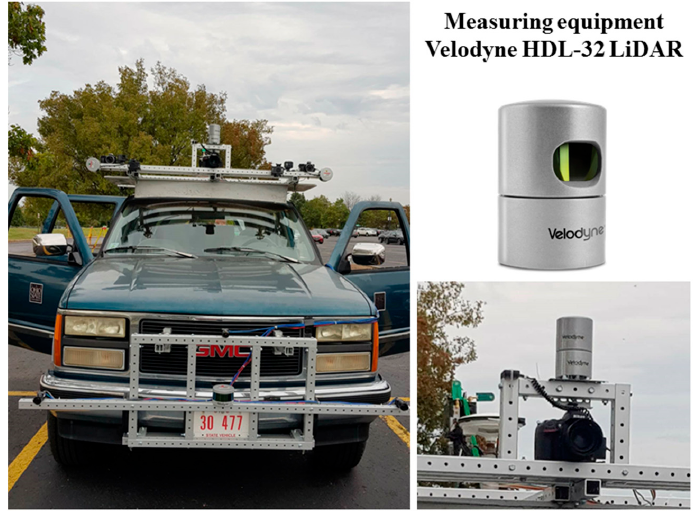
Figure 4. Vehicle with measuring equipment, with Velodyne HDL-32 LiDAR.